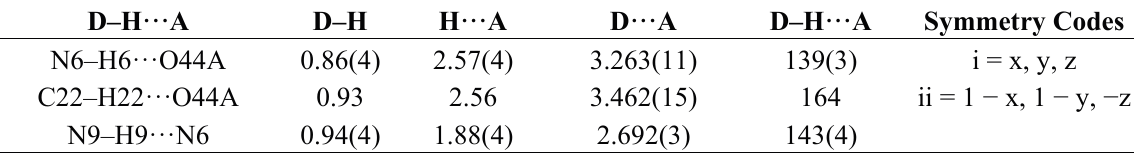
Table 3. Hydrogen bonding geometry (Å, °) for compound 4f